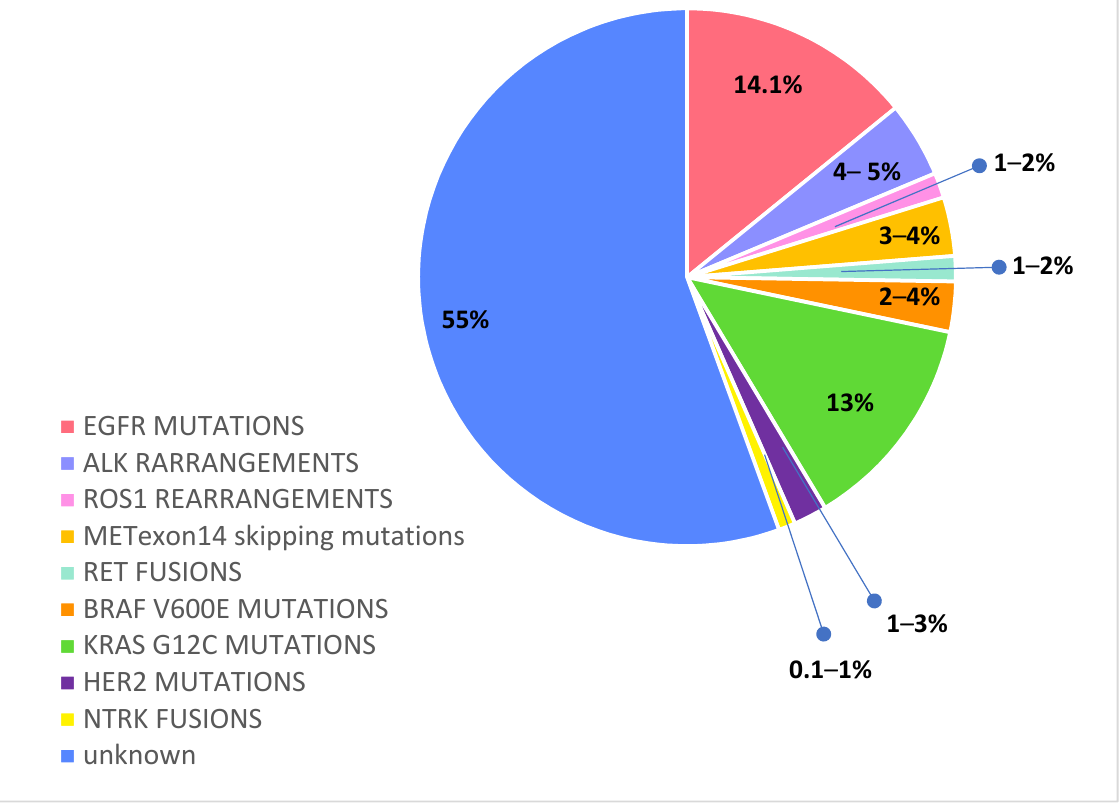
Figure 2. Druggable molecular alterations with tailored treatments in oncogene-addicted NSCLC.